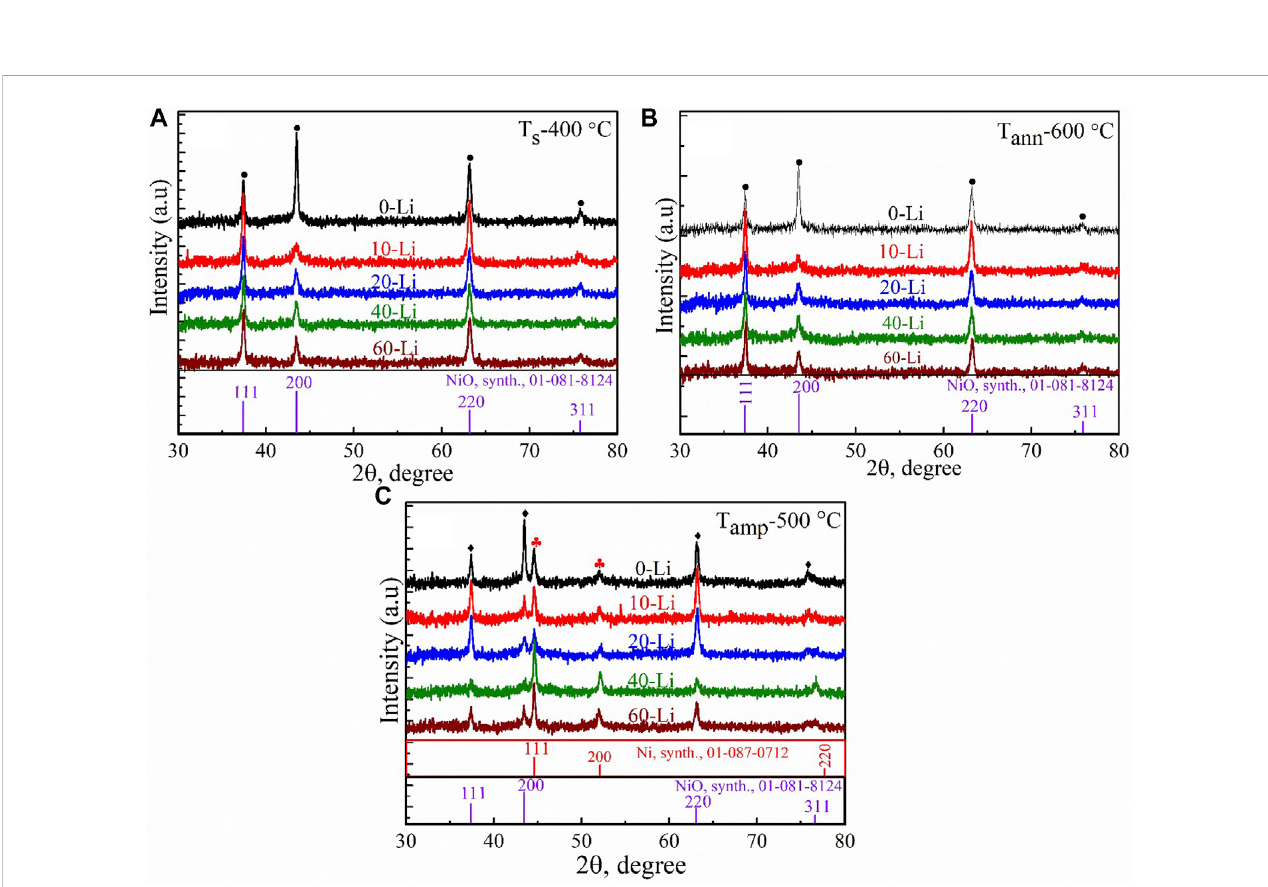
FIGURE 5 X-ray diffraction patterns for (A) (0 – 60)-Li:NiO x thin fi lms deposited at 400 ° C from methanol-based precursor, (B) after annealing at 600 ° C for 1 h in air, and (C) (0 – 60)-Li:NiO x thin fi lms after annealing in evacuated ampules at 500 ° C for 1 h. The solid black diamonds represent the crystallographic re fl ection peaks of cubic NiO, while the solid red clubs represent that of metallic